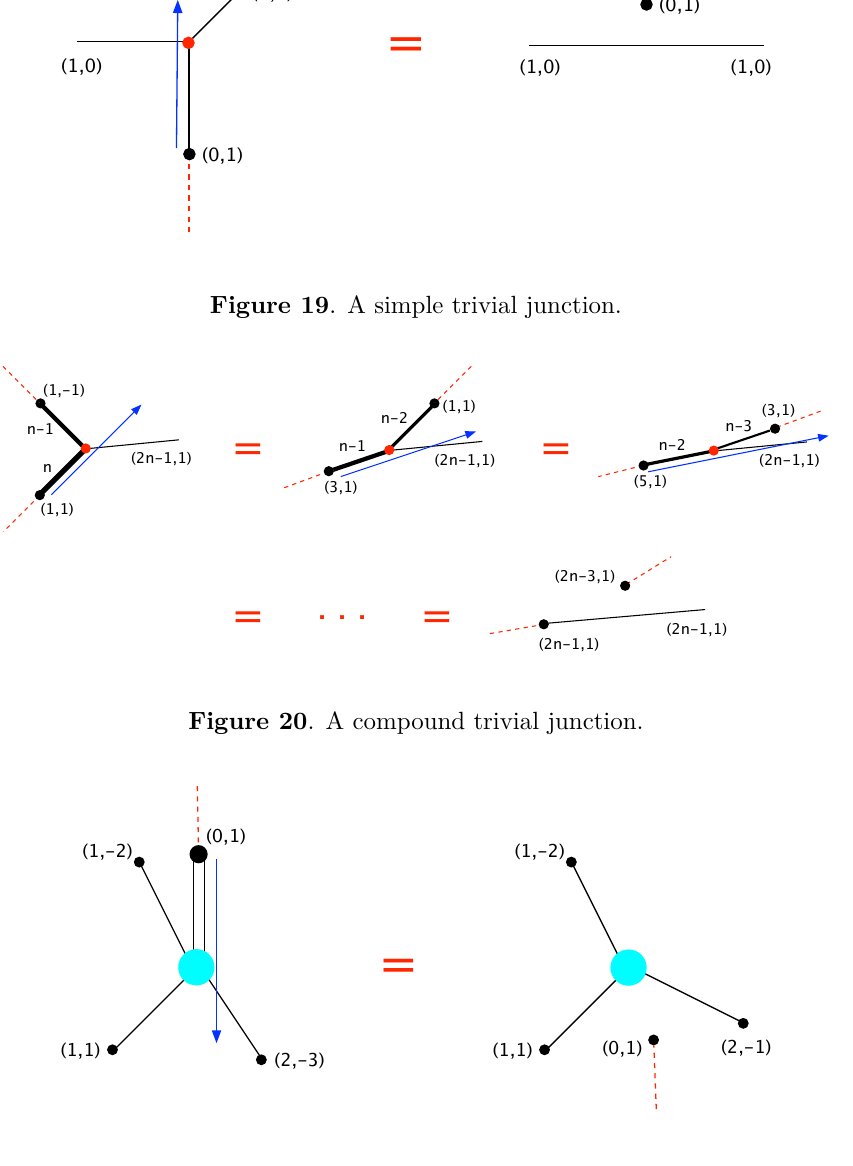
Figure 21 . An example of a 1-trivial 4-junction describing the E 0 theory plus a free